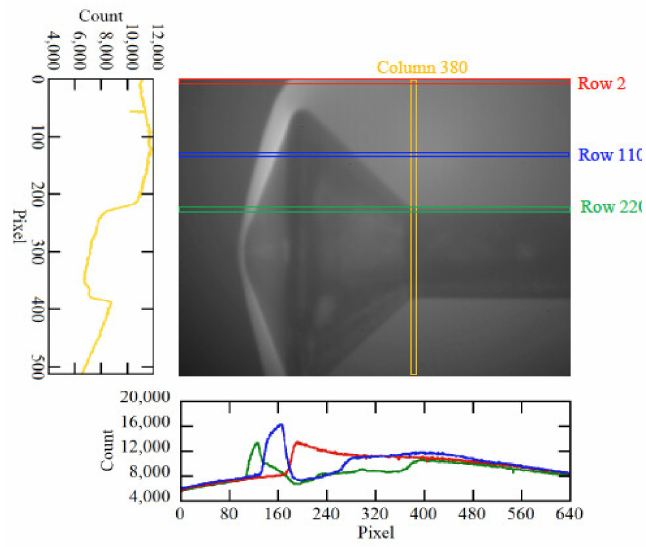
Figure 35. Spatial distribution of IR radiation intensity at 5.5 km/s (from [33]).